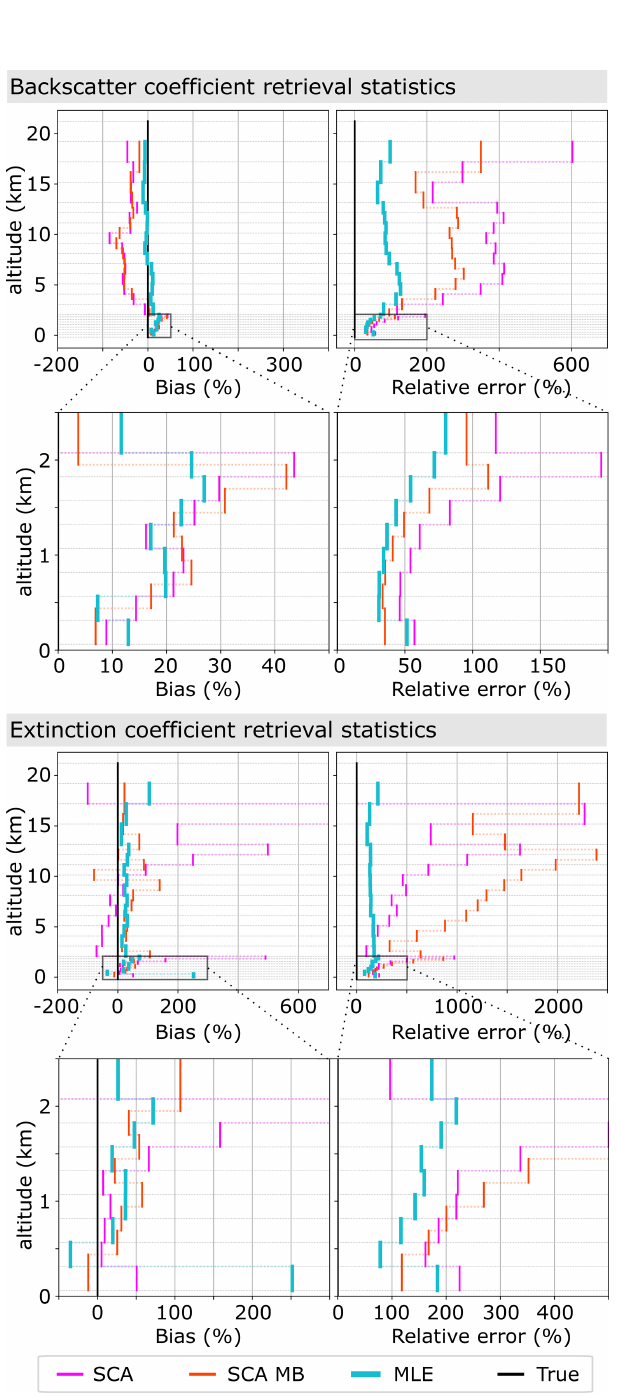
Figure 3. Simulation case I: retrieval statistics for backscatter and extinction coefficients obtained from the mean profiles from Fig. 2. Left: bias relative to simulation input parameters. Right: standard error relative to simulation input parameters. Please note the varying x -axis